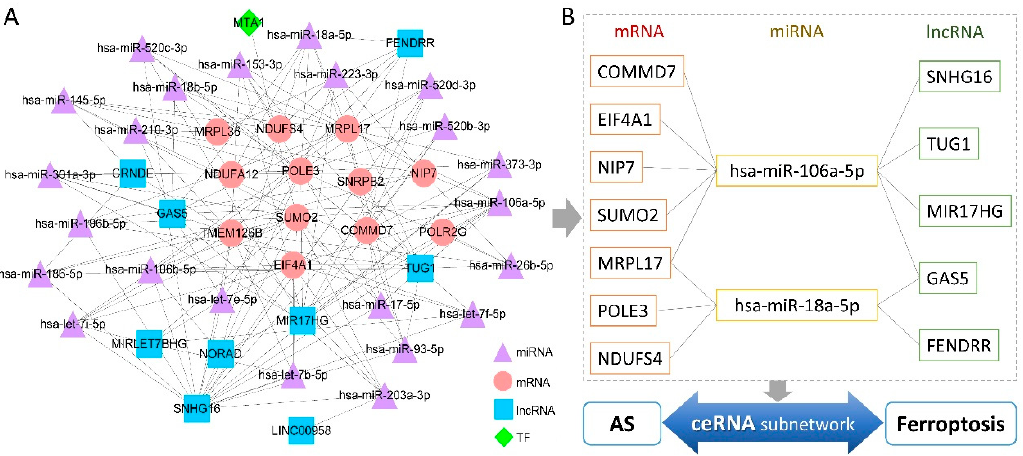
Figure 9. ( A ) Multifactor regulatory network based on the 12 hub genes. The network was constructed using the interaction data from the TRRUST v2 database and the RNAInter v4.0 database. The circles represent hub genes. The triangles represent micro RNA. The square represents long non-coding RNA. The diamonds represent transcription factors. ( B ) Novel competing endogenous RNA subnetwork extracted from the whole regulatory network. Only nodes with high connectivity (degree > 5) were included.